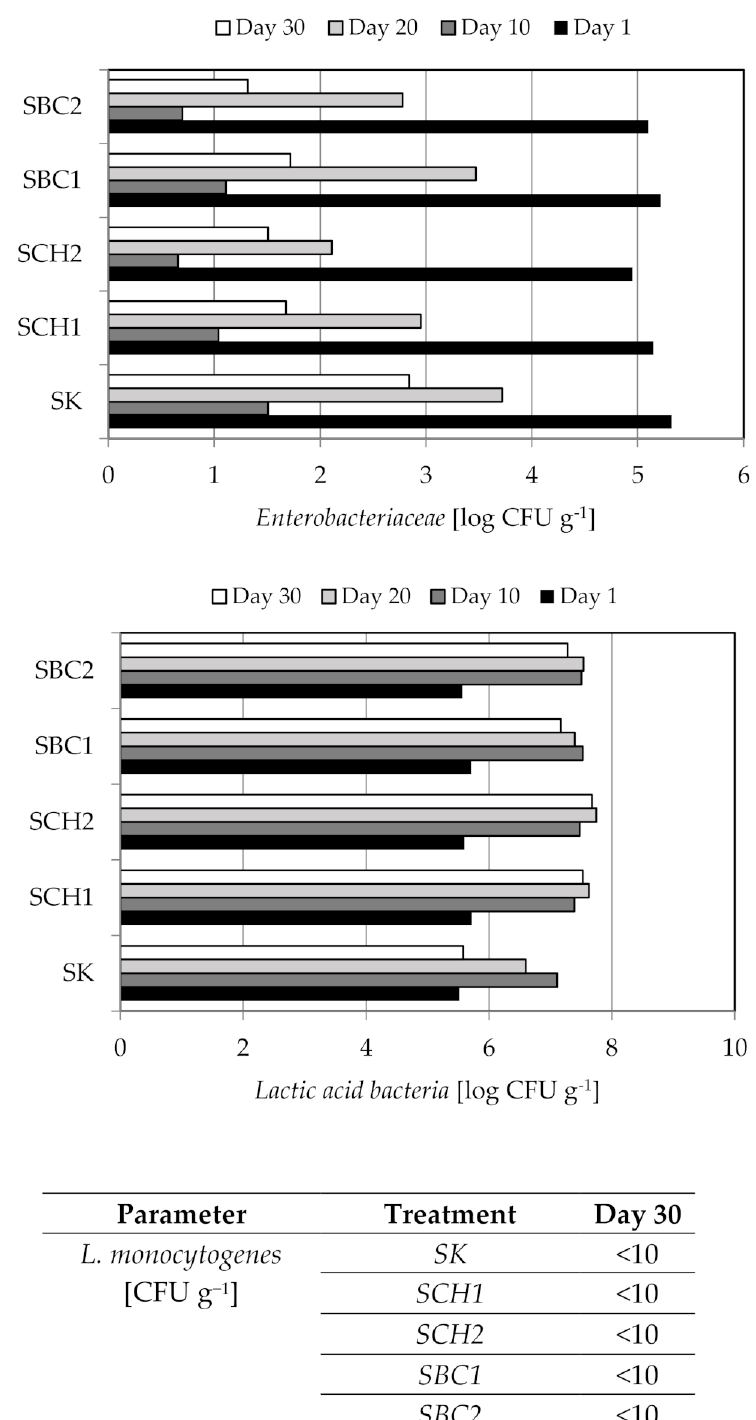
Figure 2. The results of microbiological analyzes during the manufacturing process of dry fermented sausages. SK—control sample; SCH1—sample with 1% addition of chia seed; SCH2—sample